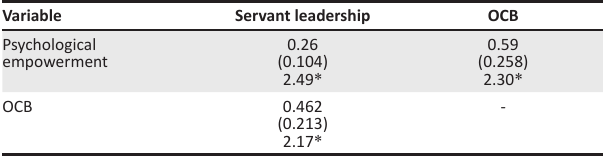
OCB, organisation citizenship